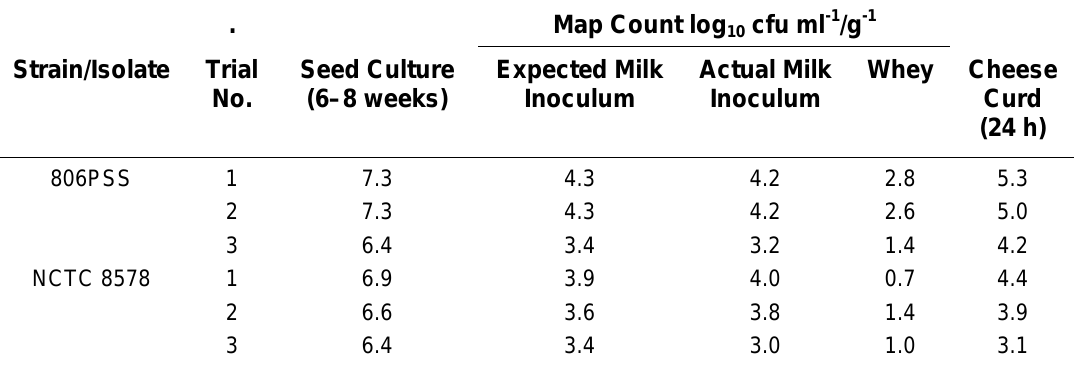
cfu ml -1 /g -1 10